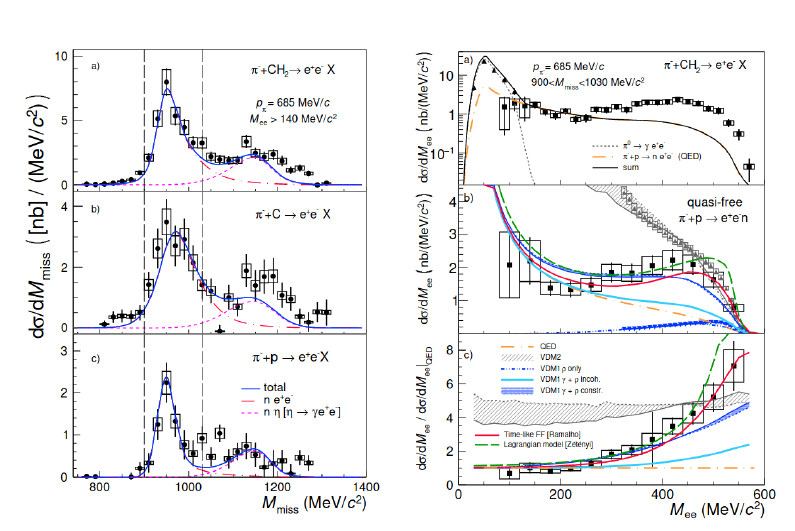
Figure 7. In-medium dielectron spectrum in Au + Au collisions at HADES in comparison with calculations for the ρ line-shape [3].